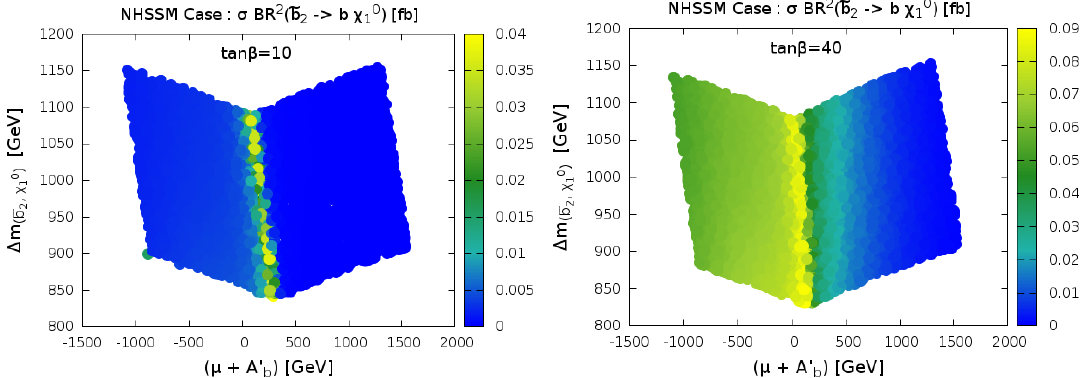
Figure 13 . Variation of parton-level yields in the 2 b + (cid:31) 0 ~ b 2 (in green) pair-production at the 13 TeV LHC as functions of A for tan (cid:12) = 10 (40). Other (cid:12)xed/varying parameters are as in (cid:12)gure 12. For the plot on the right, contributions from ~ b 1 and ~ b 2 are added up (in blue).